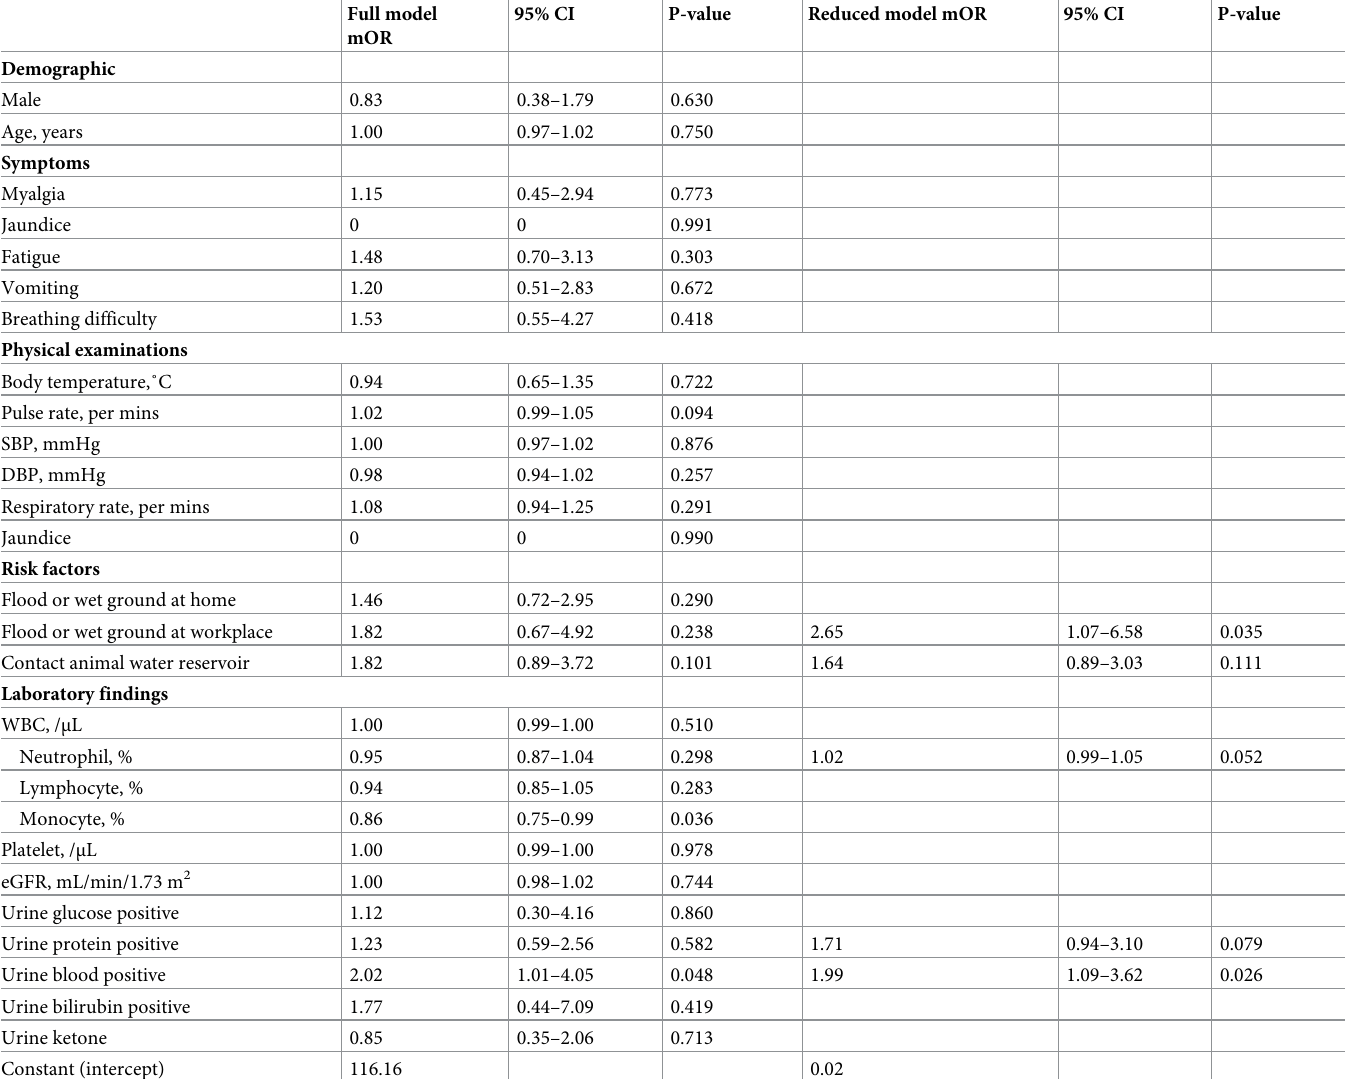
Table 2. Multivariable logistic regression